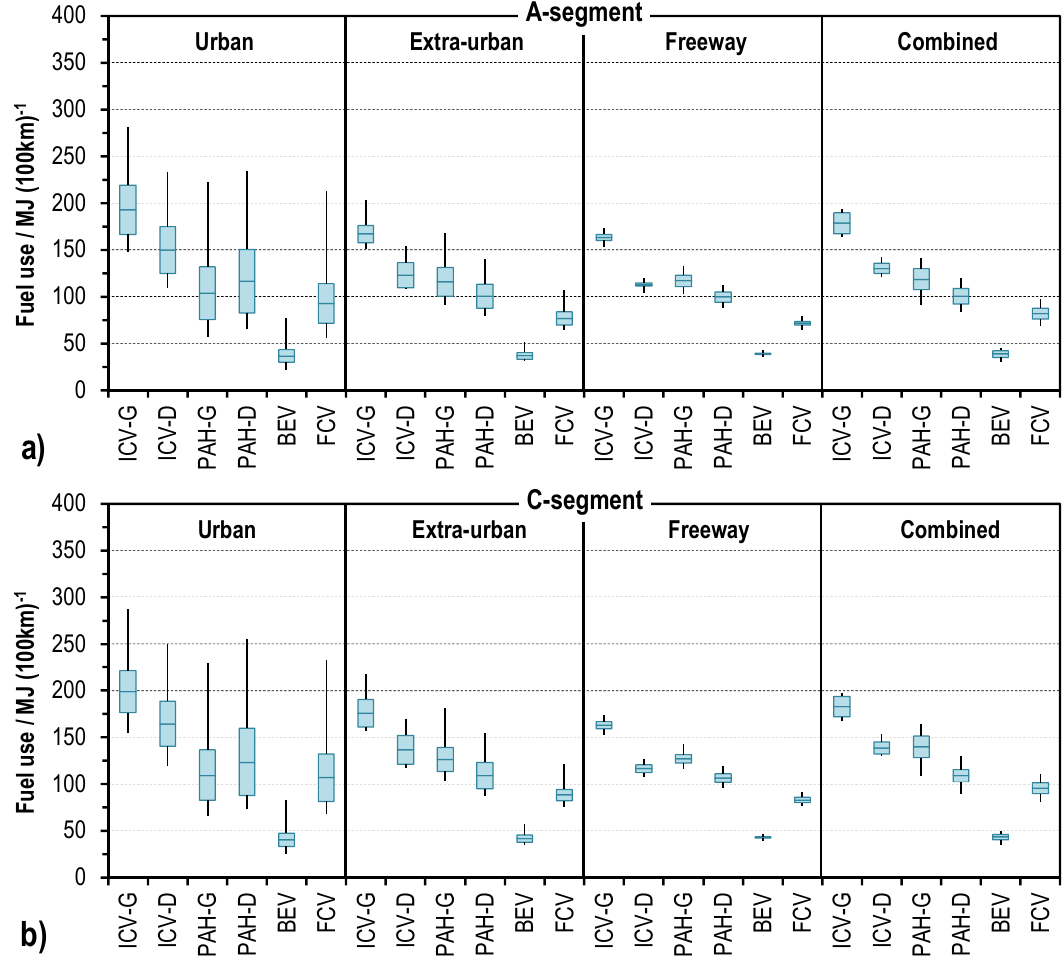
Figure 7. Results of the fuel economy analysis according to all concepts and onboard load cases related to the “advanced” scenario, for ( a ) A-segment and ( b ) C-segment cars. Values are displayed as box plots related to the cycle groups of urban, extra-urban, freeway and combined with (from below): minimum, third quartile, median, first quartile and maximum. A similar figure with values related to the “standard” scenario is available in the Appendix A, Figure A1.